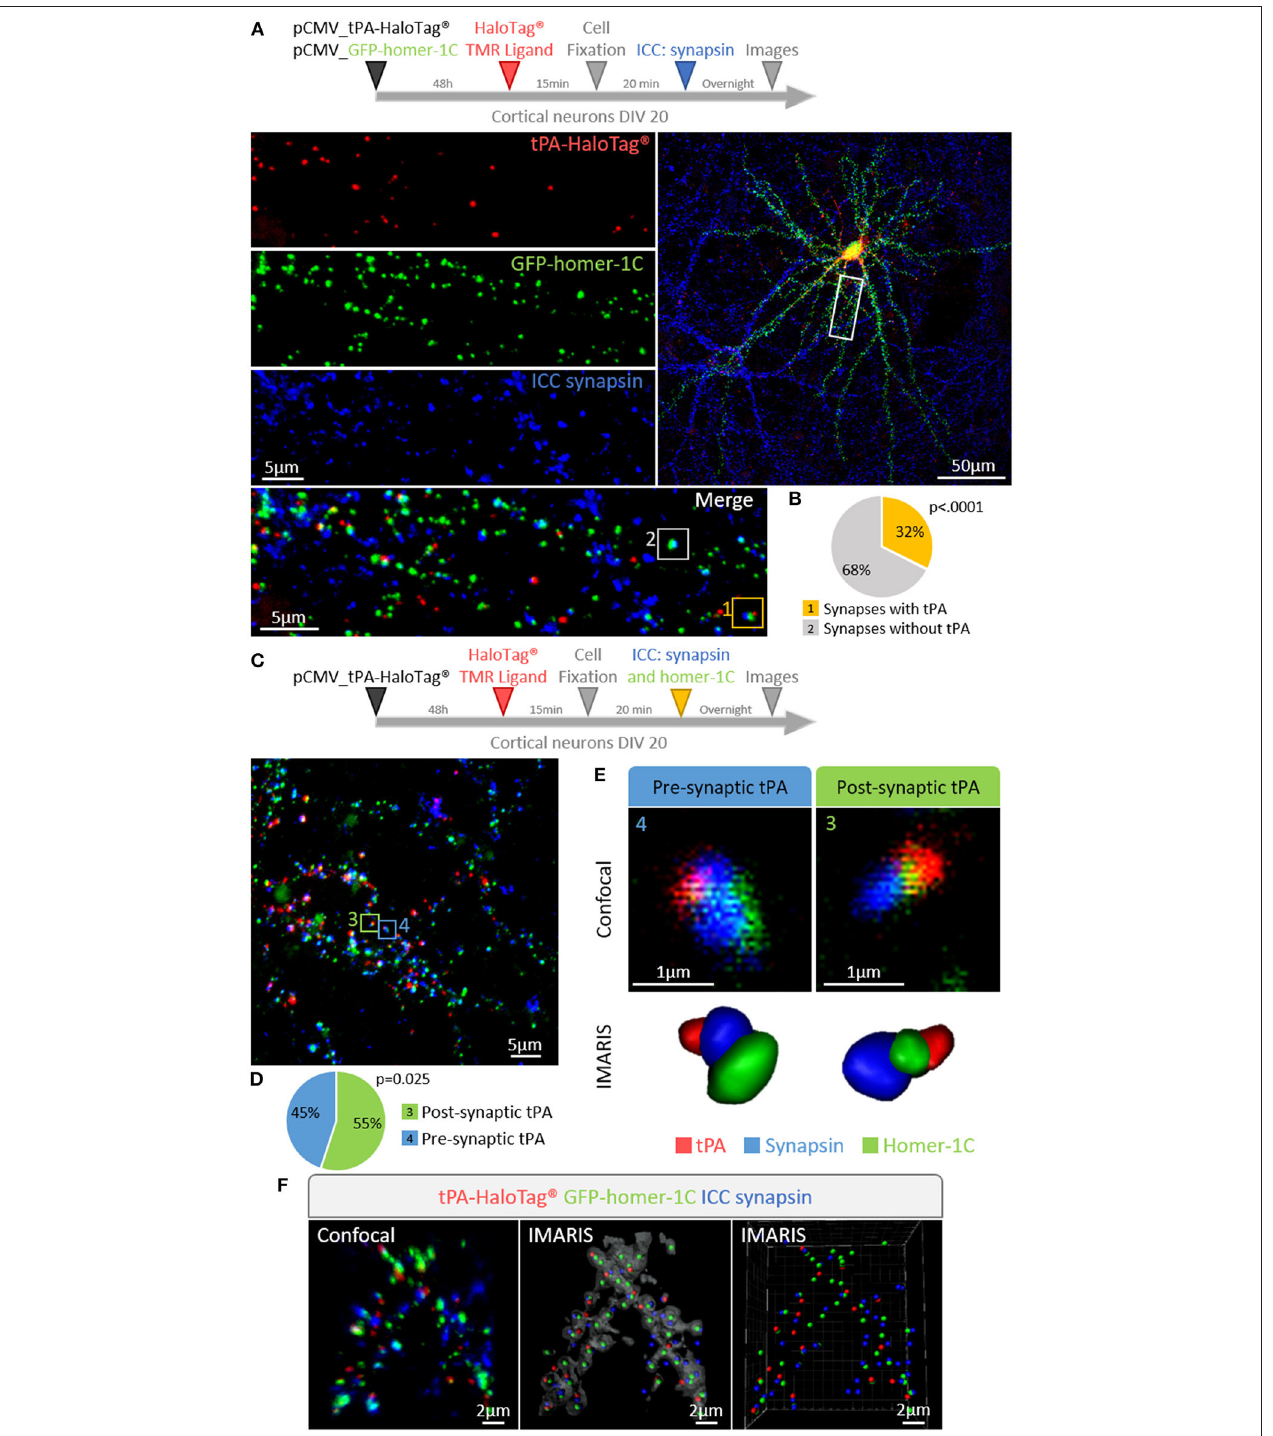
FIGURE 4 | tPA is present in pre- and post-synaptic elements. (A) Timeline of the experiments. Representative z-stack confocal images of cortical neurons (at DIV 20) co-transfected with pCMV_tPA-HaloTag ® and pCMV_GFP-homer-1C plasmids followed by immunocytochemistry raised against synapsin. tPA-HaloTag ® (TMR ligand, in red) is present at synapses revealed by the presence of GFP-homer-1C (post-synaptic protein, green) and synapsin (pre-synaptic protein, blue).ScaleBar:5or50 µ m(wholeneuron). (B) RepresentativediagramsshowingthepercentagesofsynapsescontainingornottPA-HaloTag ®